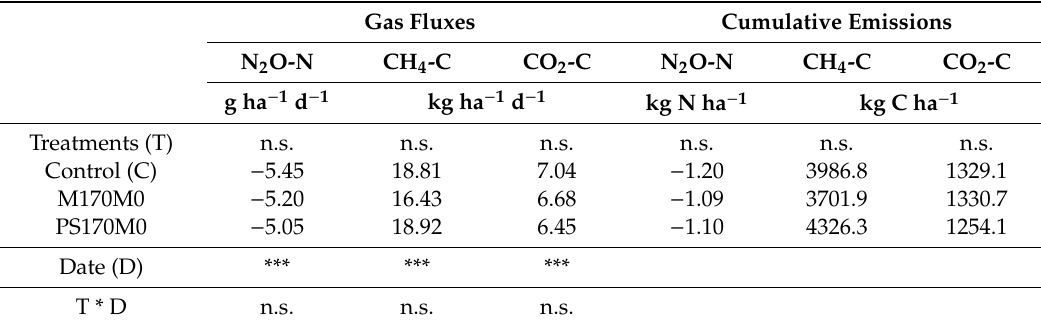
Table 5. Site 2 (Grañ é n, 2014). Average fluxes of N 2 O, CH 4 , and CO 2 and cumulative N 2 O, CH 4 , and CO 2 emissions during the studied period, for the di ff erent N fertilization treatments, indicating the e ff ects of treatment (T), date of sampling (D), and their interaction (T *